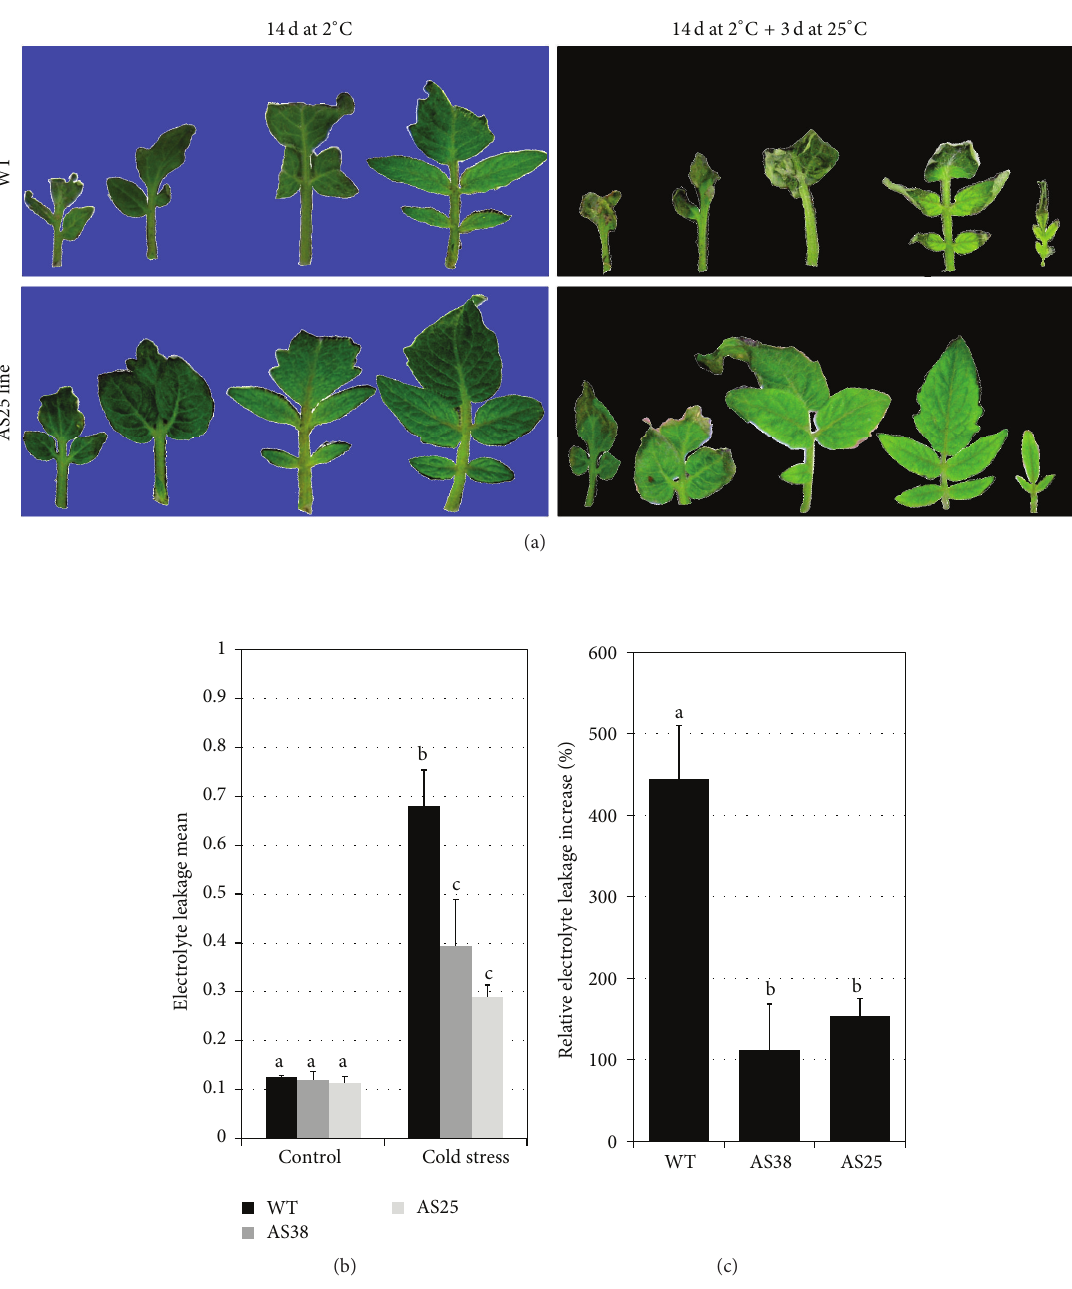
Figure 5: Cold stress effect on wild type and Sl-ERF.B.3 antisense lines. (a) Photographs of both Sl-ERF.B.3 antisense transgenic tomato lines (AS25) and wild type (WT) were taken after 14 days of cold treatment (2 ∘ C) then three days of recovery (25 ∘ C). Control: plants were grown under normal growth conditions. (b) Electrolyte leakage means are assessed in two Sl-ERF.B.3 antisense transgenic tomato lines (AS25 and AS38) and in wild type (WT) treated or nontreated by incubation at 2 ∘ C temperature during 14 days. (c) Percentages of relative increase in electrolyte leakage between control (maintained at 25 ∘ C) and cold stressed (incubated at 2 ∘ C) plants of both wild type (WT) and Sl-ERF.B.3 antisense transgenic lines (AS25 and AS38). Data are means of three replicates ± standard error. Same letters and different letters indicate, respectively, nonsignificant differences and significant differences between data, according to Student’s 𝑡